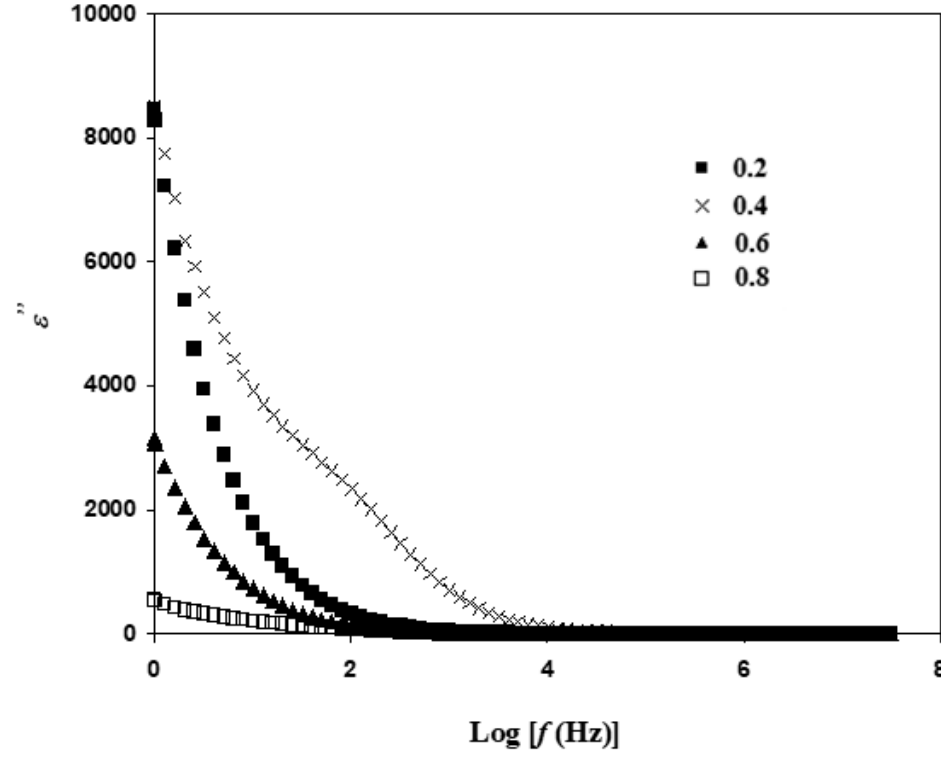
Figure 9. Variation of 𝜀 ’’ at different frequencies for Li 1+x Al x Ti x Sn 2-2x (PO 4 ) 3 at sintering temperature of 650 °C.